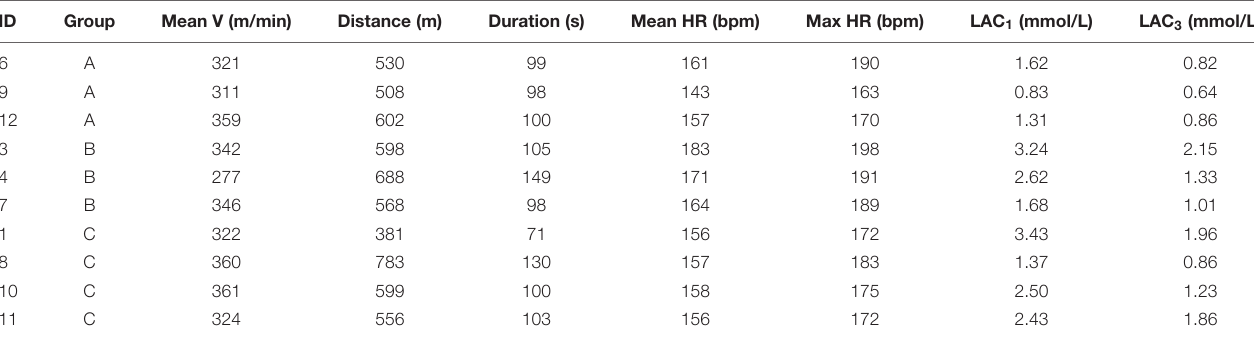
TABLE 5 | Speed, distance, duration, mean and maximum heart rate, and post-exercise blood lactate concentration in response to the standardized grid exercise (SET grid